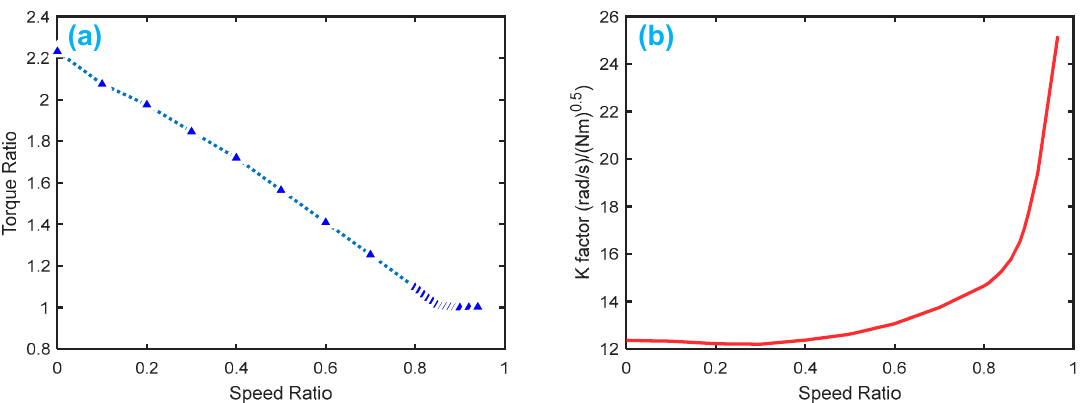
Figure 9. Torque converter characteristics: ( a ) torque ratio by speed ratio; ( b ) K-factor by speed ratio.